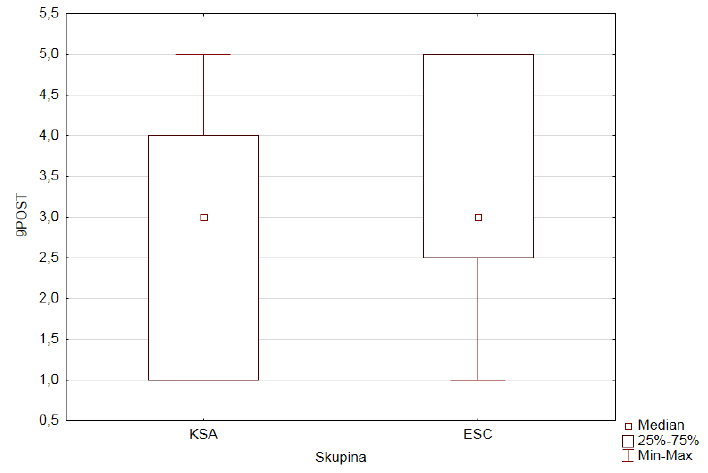
Figure 14. The box graph of the ninth item of the posttest - 9POST.